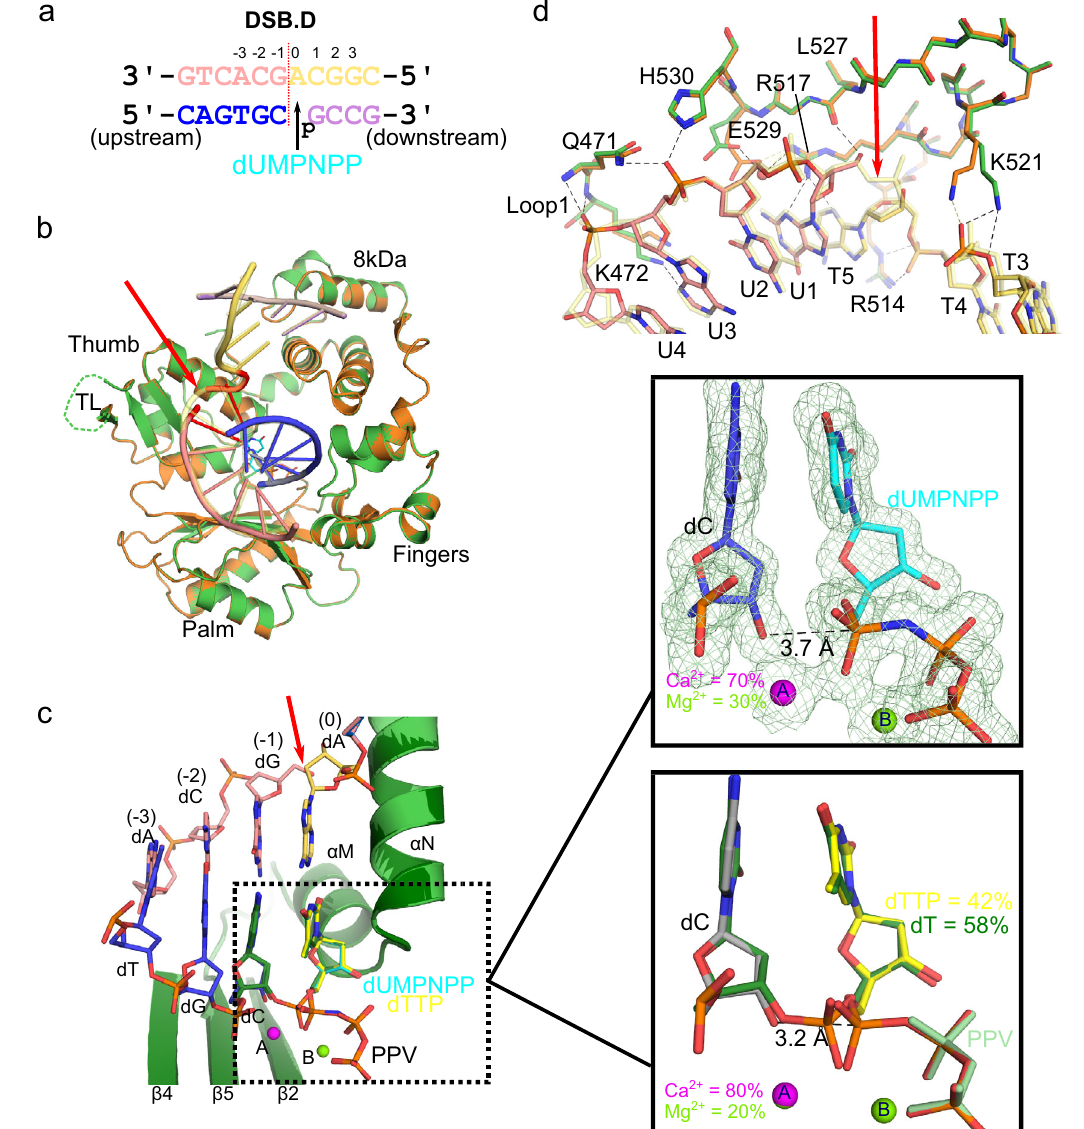
Fig. 8 Pol λ can address blunt-ended DSBs and SSBs in a similar manner. a Blunt-ended DSB substrate (DSB.D) co-crystallized with the Pol λ catalytic domain. The break site is indicated (red dashed line). Upstream (left) template and primer (pink and blue, respectively) are annealed separately from the downstream (right) template (pale orange) and primer (lavender) strands, and synapsis is mediated entirely by the polymerase. The DSB.D pre-catalytic quaternary complex is formed by addition of the nonhydrolyzable incoming dUMPNPP (cyan) nucleotide. b Global superposition of the pre-catalytic SSB ternary (orange) and blunt-ended DSB quaternary (protein in green, DNA and incoming dUMPNPP colored as in a ) complexes. c Structure of the DSB.D substrate bound in the Pol λ active site, with the pre- (protein in light green, DNA and incoming nucleotide colored as in a ) and partially incorporated (protein and DNA in dark green, unincorporated hydrolyzable incoming dTTP nucleotide in yellow, PDB ID code 7M0A) substrates, with zoomed-in views of each complex included to the right (top, pre-catalytic, with 2 F o -F c electron density contoured to 1 σ ; bottom, partially incorporated, with unincorporated primer terminus and dTTP in gray and yellow, respectively). The Ca 2 + and Mg 2 + ions are shown as magenta and green spheres, respectively. Though the metal in the B site is modeled at full occupancy, based on geometry and coordination distances, a mixture of metals is observed in the A site. Occupancies for the metal A site mixture and newly incorporated nucleotide are indicated in each case. d Superposition of the pre-catalytic SSB (protein residues in orange, DNA template in transparent pale yellow) and blunt-ended DSB.D substrates (protein in green, DNA template strands colored as in a , water molecule as red sphere) for comparison of interactions surrounding the DSB break site (red arrow). Hydrogen bonding interactions with the DSB or the SSB are drawn as dashed lines (black or yellow,